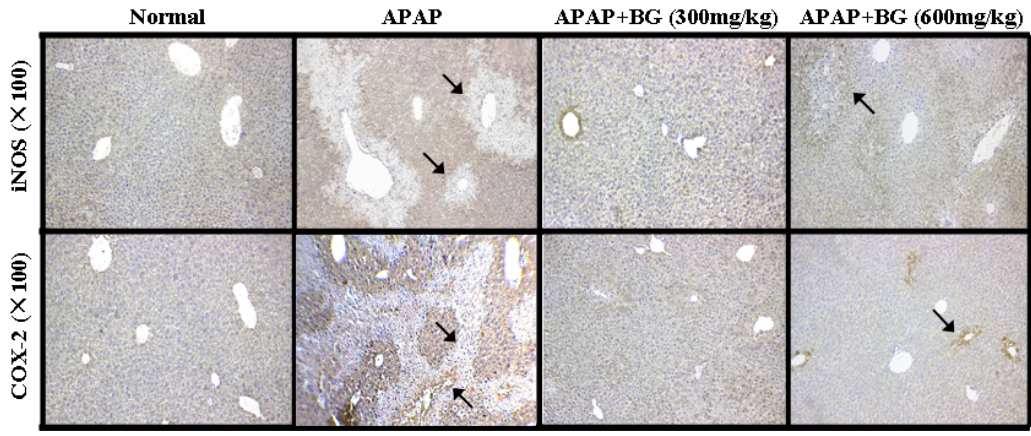
Figure 6. Effects of BG on expression of COX-2 and iNOS in liver tissues. Arrows show necrotic and inflammatory cells.